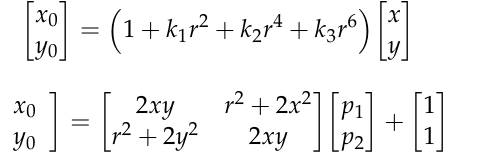
new position to the center of the lens, k 1 , k 2 and k 3 are the radial distortion parameters, and In an ideal binocular stereo vision system, the left and right camera imaging planes are coplanar, and row aligned. However, in practice, the two planes are deviated. The purpose of the stereo correction is to correct this deviation. The stereo correction process is shown in Figure 12.